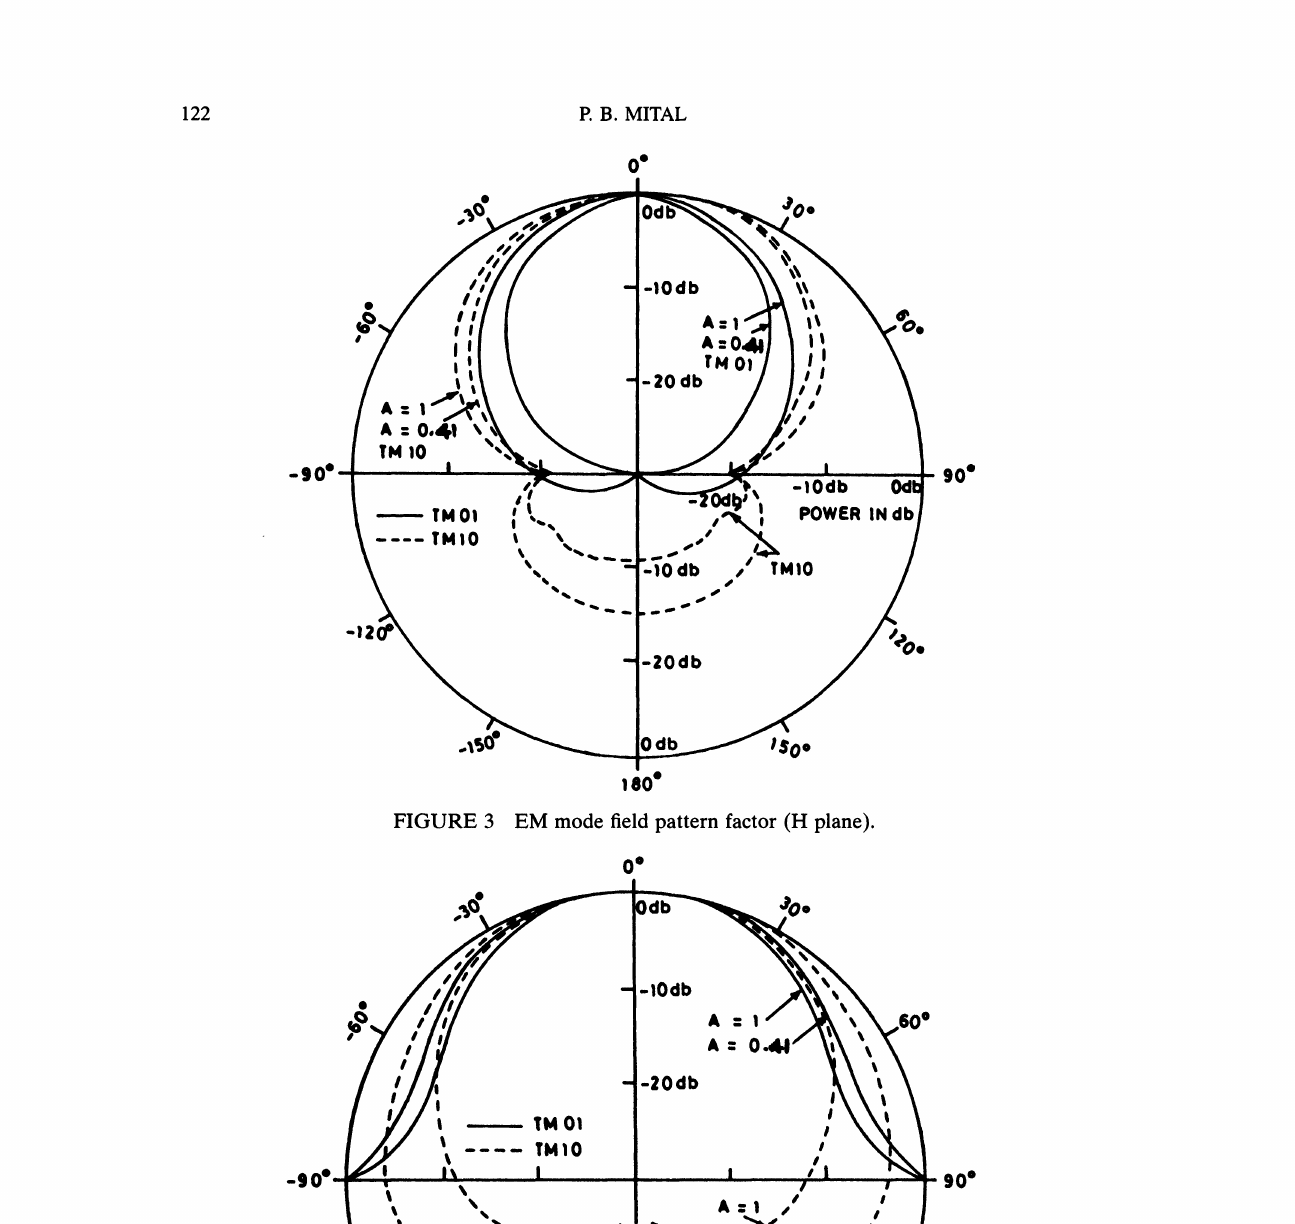
FIGURE 4 EM mode field pattern factor (E